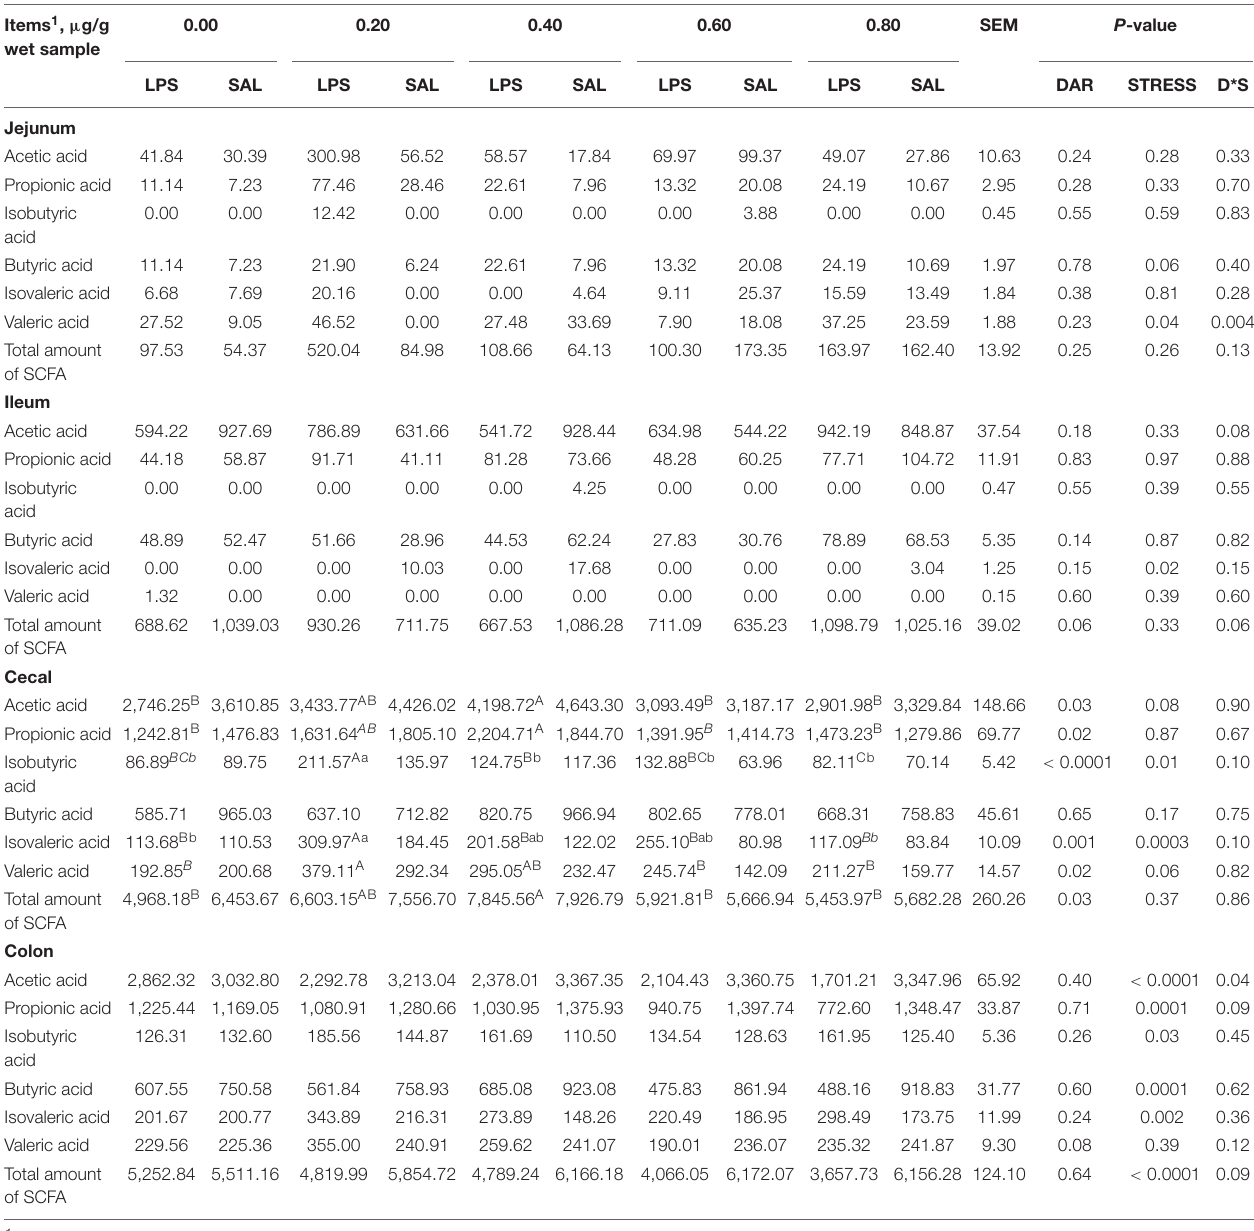
TABLE 5 | Effect of DAR on concentrations of VFAs in the digesta of weaned piglets challenged with E. coli LPS. Items 1 , µ g/g